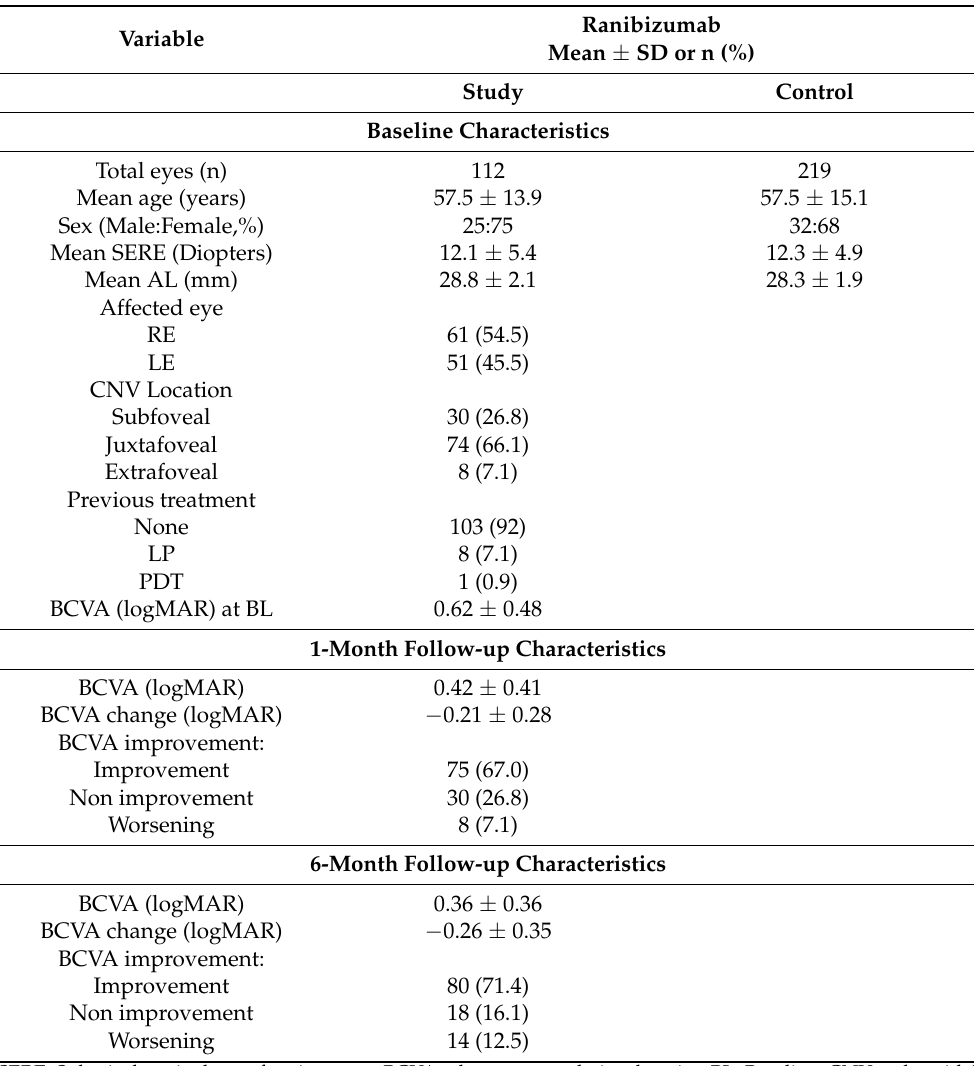
Table 2. Baseline characteristics of